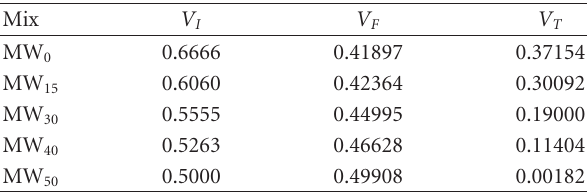
Table 4: Volume fraction of EPDM due to swelling in Chloroform.